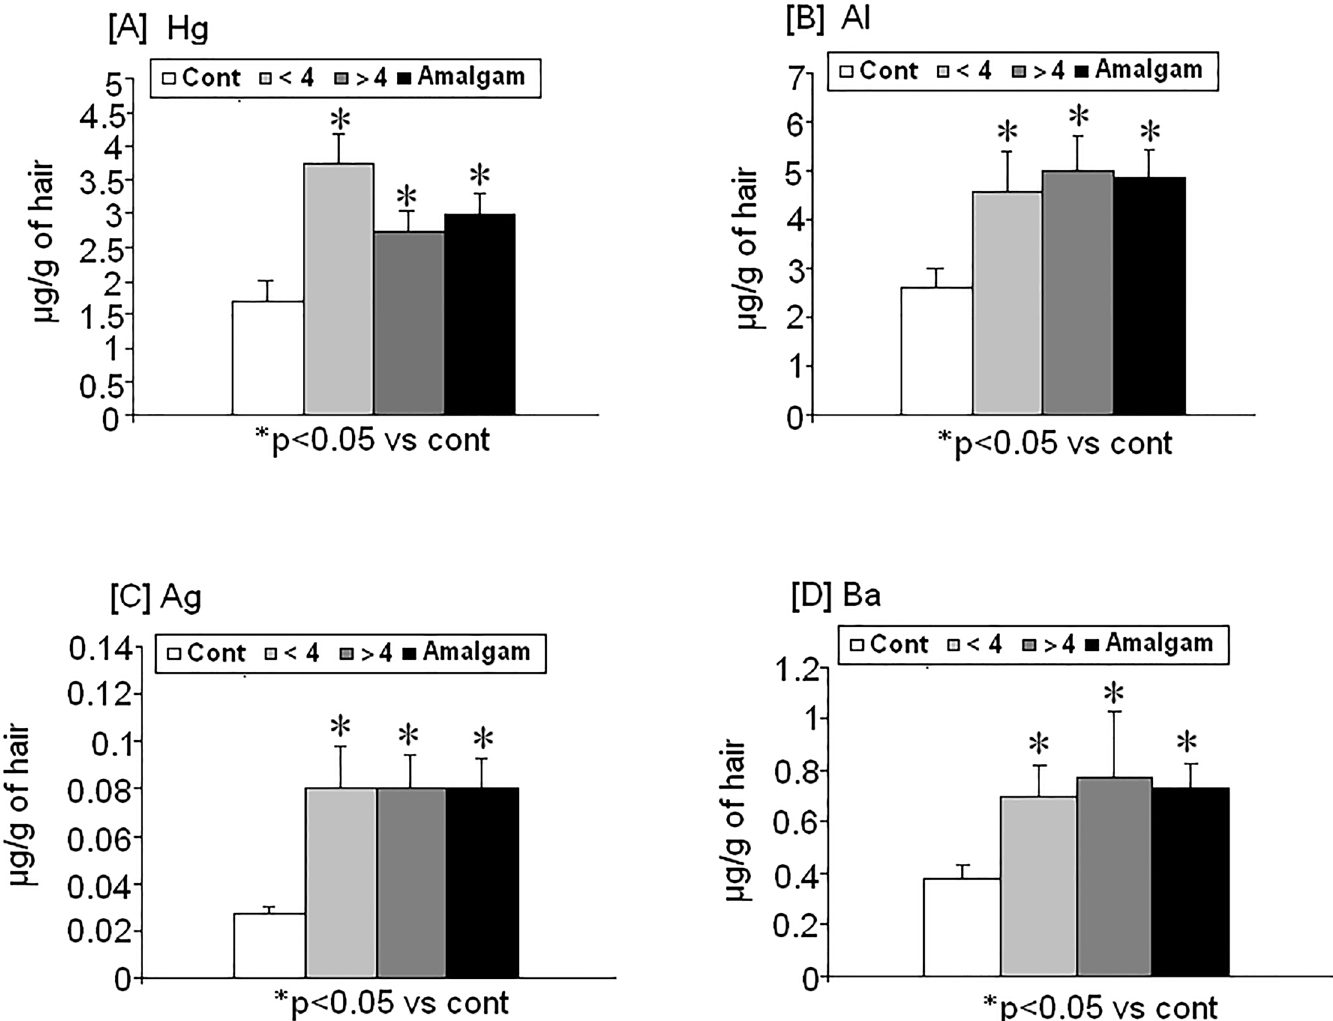
Fig 1. Changes in heavy metal levels in hair ( μ g/g of hair) from women with dental amalgam fillings for more than ten10 years (n = 42) as compared to controls (n = 13). [A] mercury (Hg), [B] aluminium (Al), [C] silver (Ag) and [D] barium (Ba). Amalgam (Pooled; n = 42); ( < 4; n = 27), ( > 4; n = 15), (control; n = 13). * p < 0.05 vs